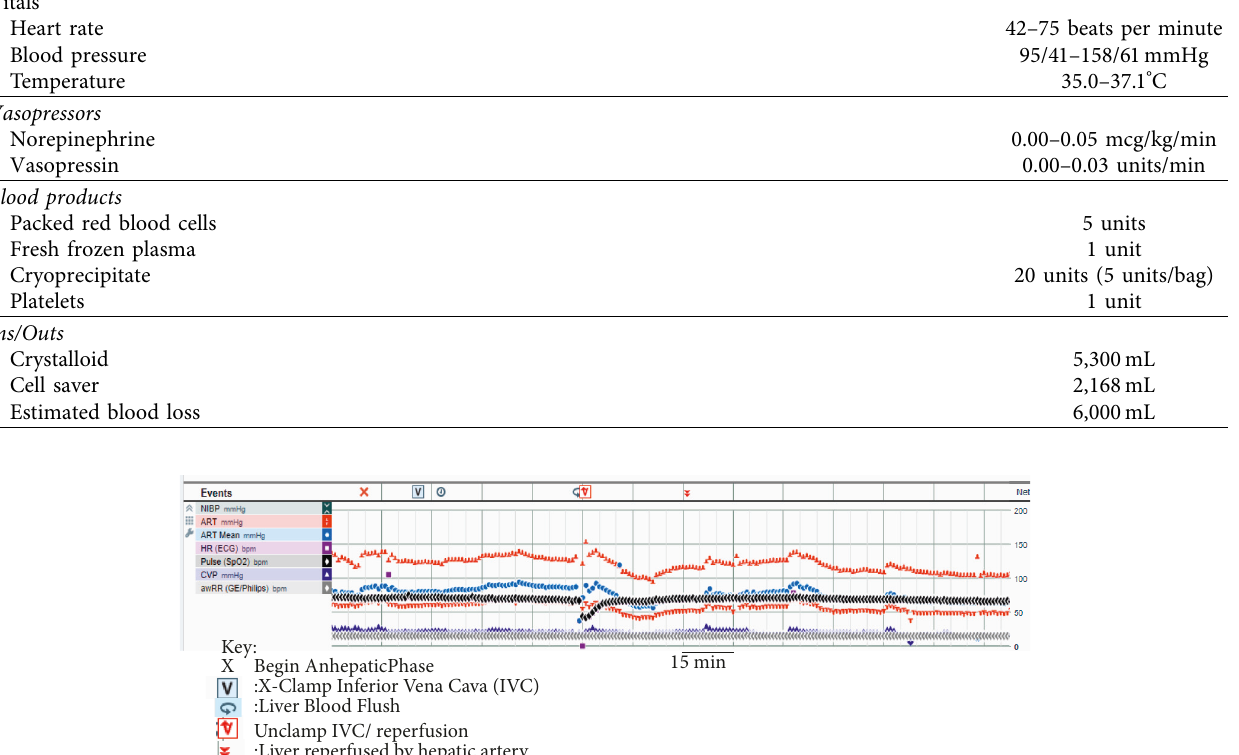
Figure 1: Intraoperative record during anhepatic and reperfusion phases. The patient exhibited marked hemodynamically stability through inferior vena cava cross clamping, anhepatic phase, and reperfusion while under TIVA general anesthetic. Key phases in the intraoperative course are described in the key. Invasive arterial blood pressure (ART; red symbols), heart rate (HR; black diamonds), central venous pressure (CVP; dark blue symbols), mean arterial pressure (ART Mean; light blue circles), and respiratory rate (awRR; grey diamonds). The dark vertical bars represent 15 minute intervals.